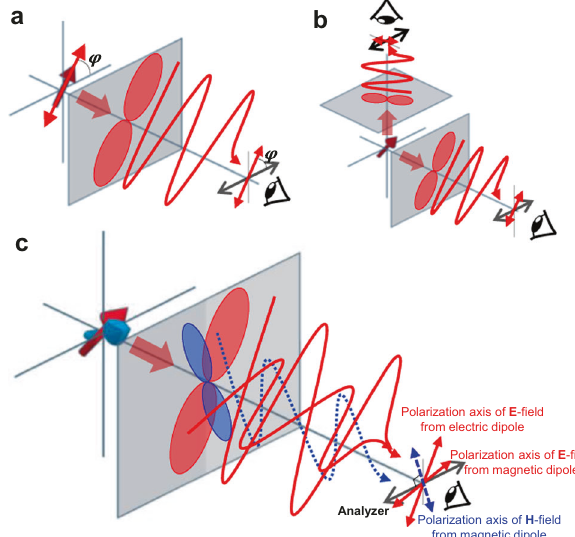
Fig. 1 Schematic illustrations of the emission dipoles and their polar diagrams. The 3D arrows indicate the emission dipoles and the dumbbells indicate the polar diagrams: the measurable fi eld intensity as a function of the angle of analyzer on the observation planes (grey plane). The wavy lines depict the oscillating electric fi eld (red) and magnetic fi eld (blue) polarized along the dipole axis. a A single electric dipole is oriented parallel to the observation plane. The dipole ’ s in-plane orientation angle can be determined from one polar diagram. b A single electric dipole with out-of- plane orientation. The projections of the dipole on two different observation planes render two polar diagrams, from which the three-dimensional (3D) dipole orientation can be determined. c Two dipoles with electric (red arrow) and magnetic (blue arrow) dipolar natures are oriented out-of-plane while they are coupled with an arbitrary fi xed angle with respect to each other. Each dipole renders a distinct polar diagram (blue dumbbell — magnetic polar diagram/red dumbbell — electric polar diagram) on the same observation plane, from which the 3D orientation of the coupled dipoles can be